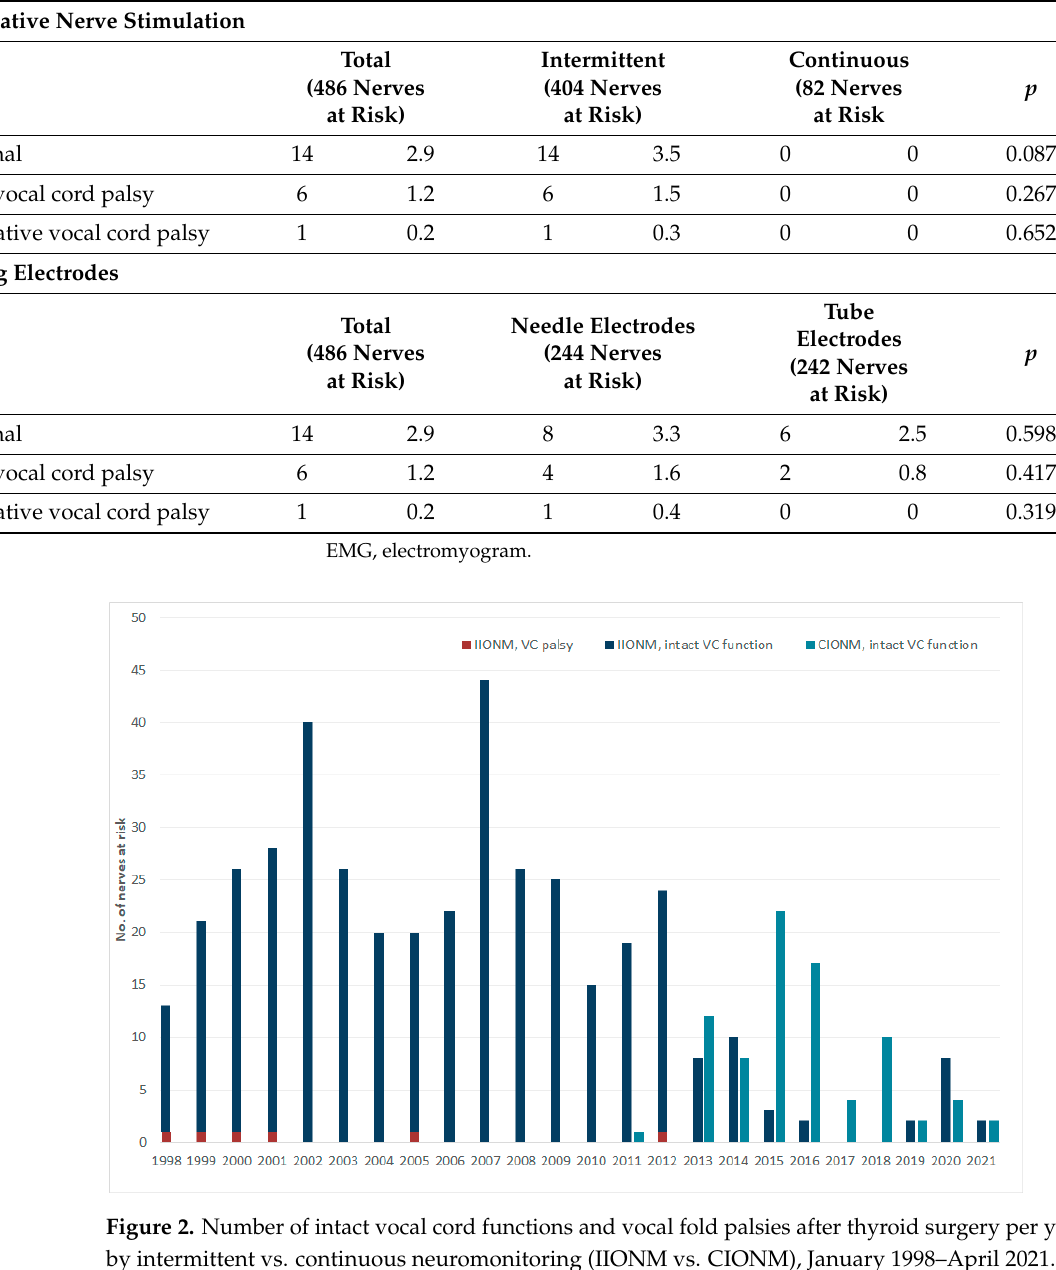
Table 3. Intraoperative loss of the EMG signal and postoperative vocal cord palsy in children with normal preoperative vocal cord function.